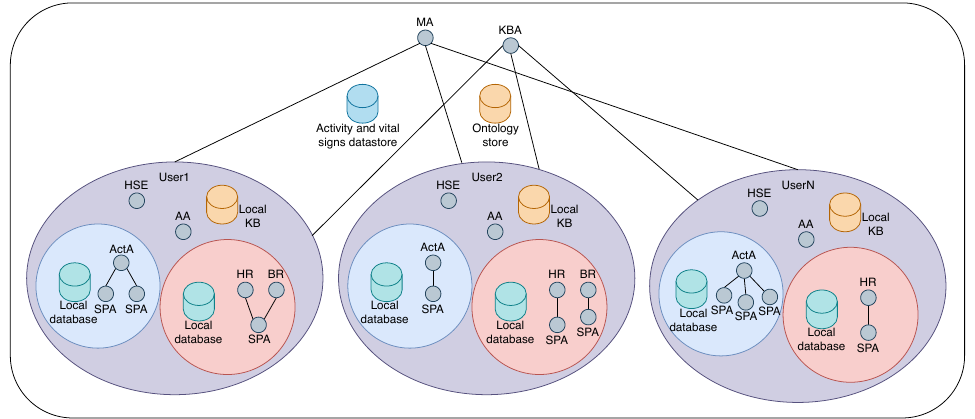
Figure 5. Hierarchical architecture and team clusters for multi-user